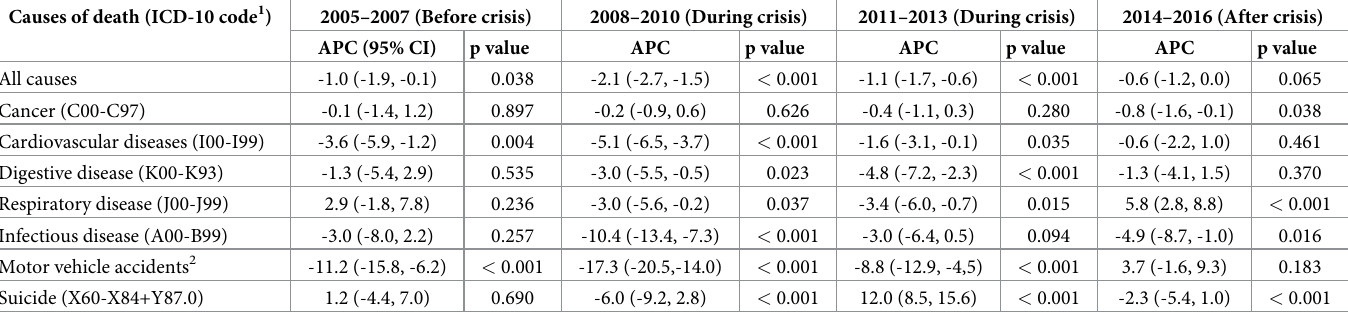
Table 4. Time trends in mortality rates by cause of death, before, during and after the 2008 economic crisis, in the Spanish women aged 15 to 64 years. Annual Per- centage Change (APC), 95% confidence interval (95% CI) and p value. Causes of death (ICD-10 code 1